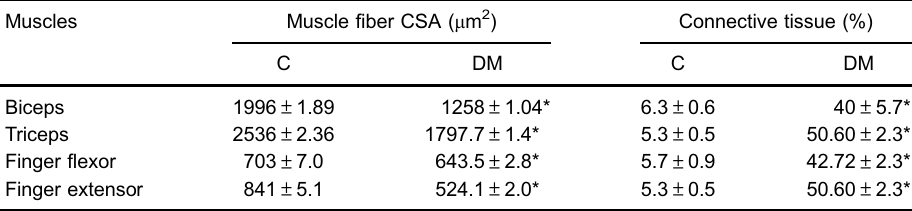
Table 2. Histological characteristics of biceps, triceps, fi nger fl exor, and fi nger extensor muscles in diabetes mellitus (DM) and control (C) groups. Muscles